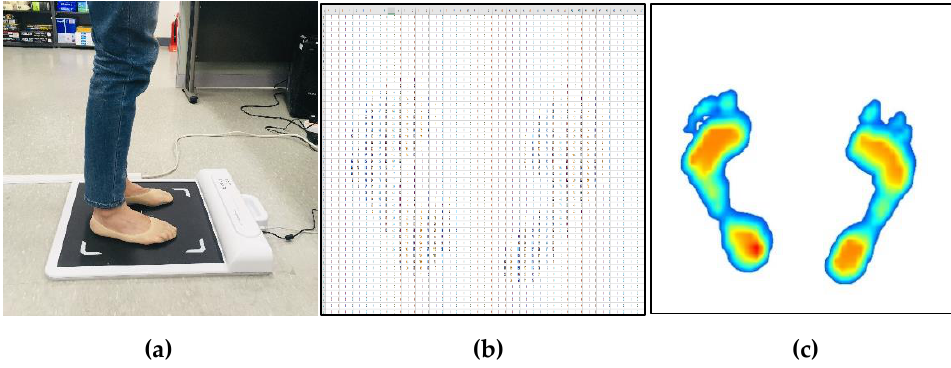
Figure 1. Experimental method and results. ( a ) Plantar pressure measurement, ( b ) numerical pressure data, ( c ) distribution of pressure image data.